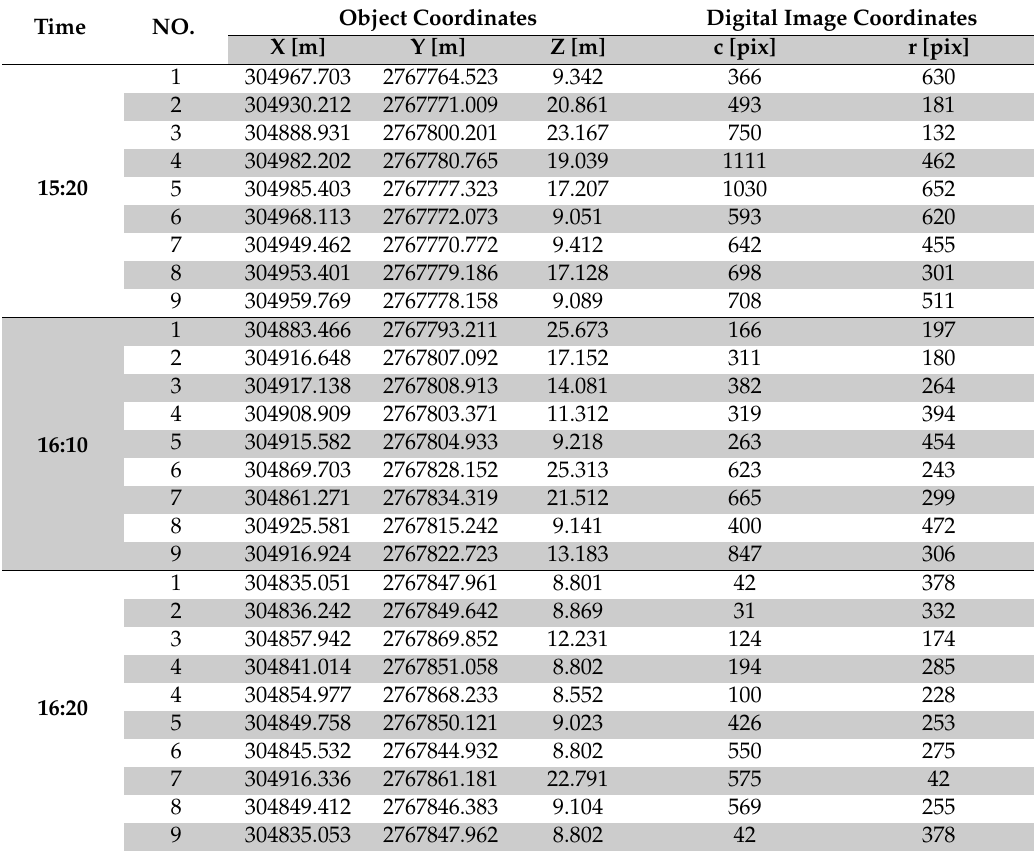
Table 2. Control point coordinates.